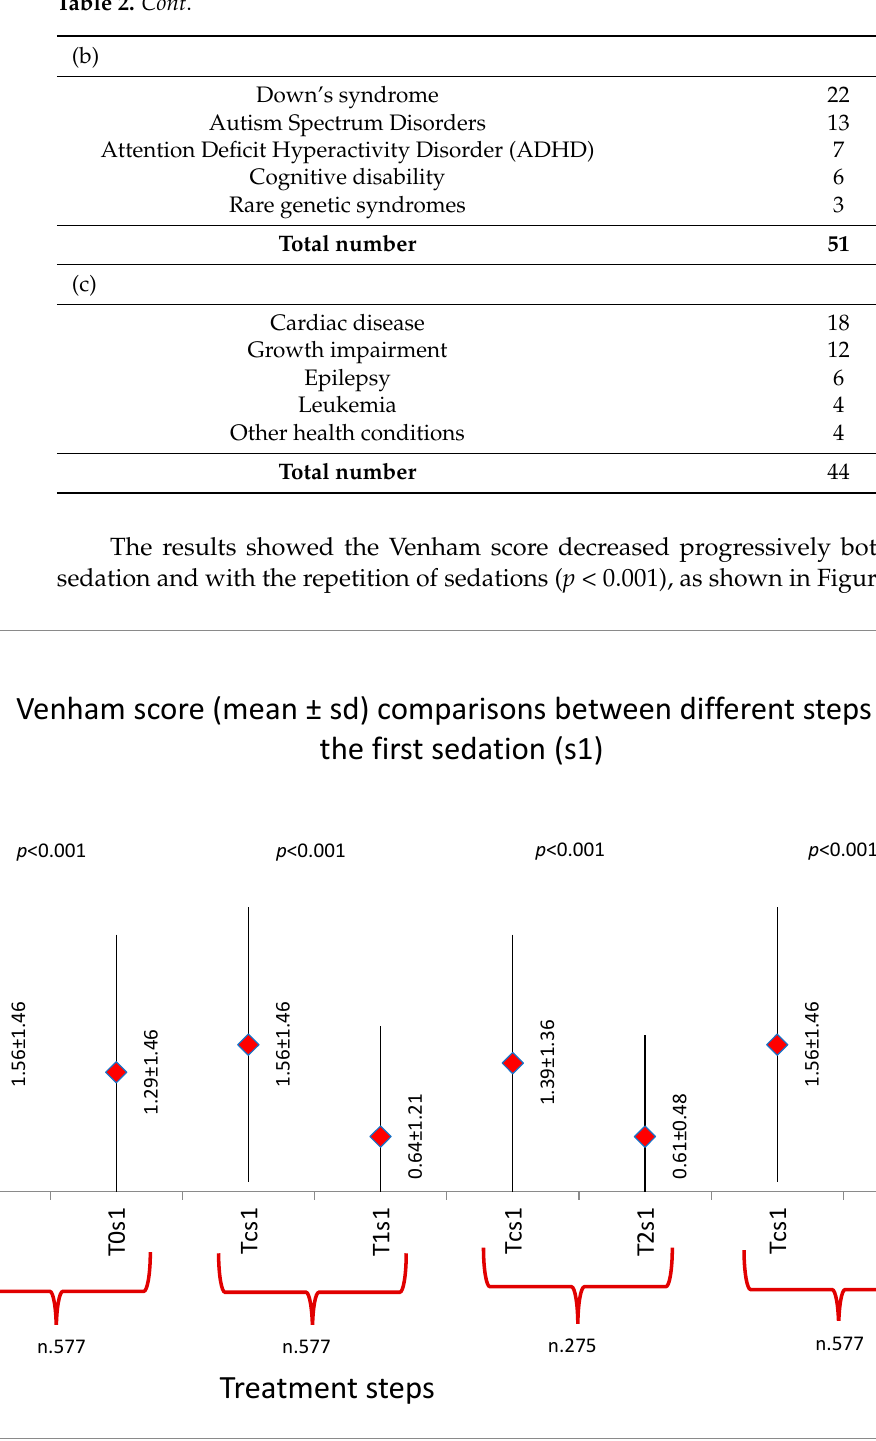
Figure 2. Venham score comparisons during the first session (s1). Tc: first contact with the dentist, T0: at the time of mask placement, T1: at least 3 min after the start of sedation, T2: during the administration of local anesthesia, T3: during the dental treatment. The sample size at step T2 for each sedation varies because not all patients received local anesthesia.